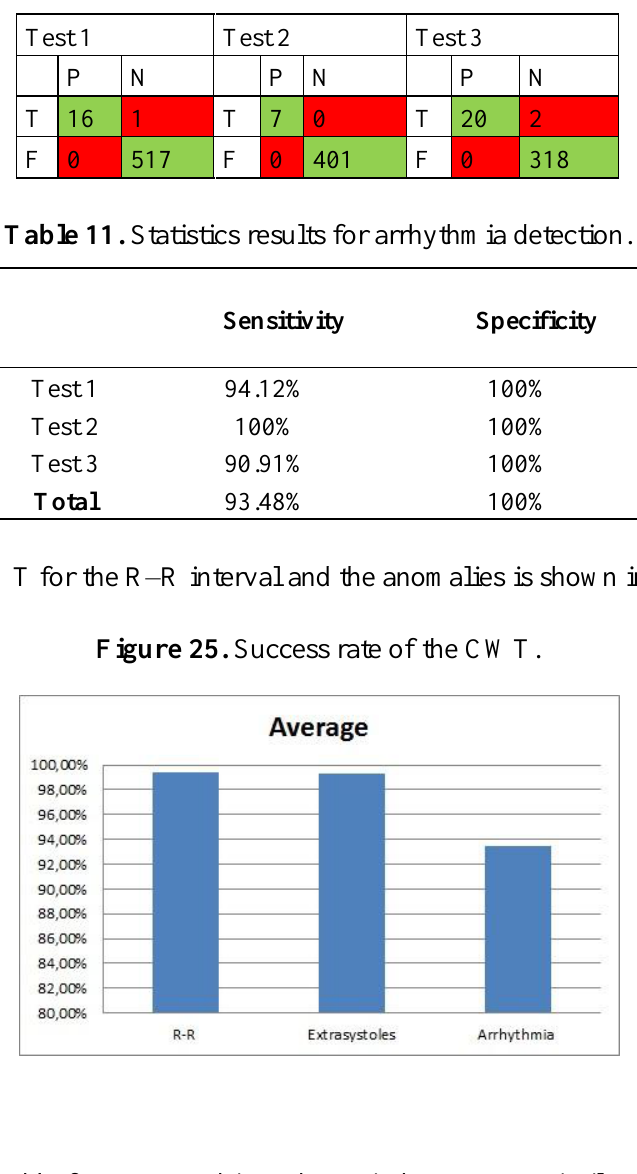
Table 10. Confusion matrix for arrhythmia detection of user 2.